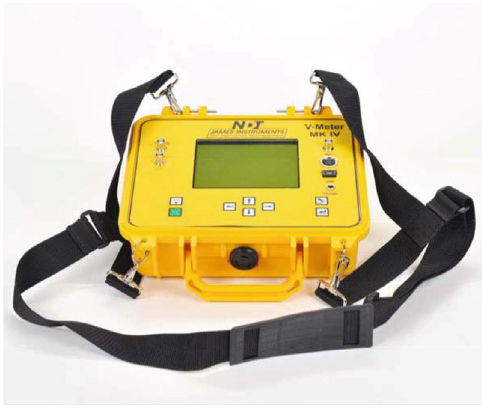
Figure 6: Ultrasonic wave